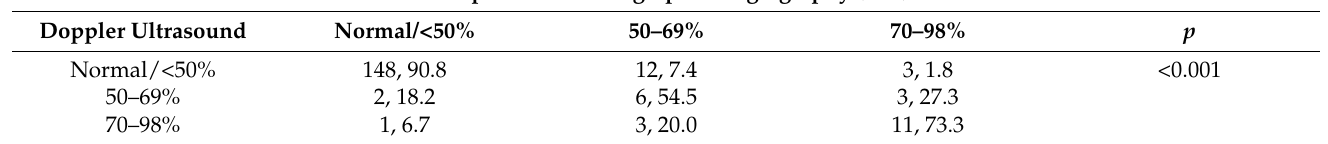
Figure 2. CT angiography showing the same patient with mild stenosis of the left internal carotid artery. The sagittal plan ( A ) presents the left common carotid artery (bulb, red arrow) and the left internal carotid artery (blue arrow). The axial plan ( B ) shows mild stenosis of the left internal carotid artery (red arrow). Table 2. Comparison of the degree of stenosis of right (RT) and left (LT) internal carotid artery by DUS and CTA. value was 47.1%, and negative predictive value was 95.3%.